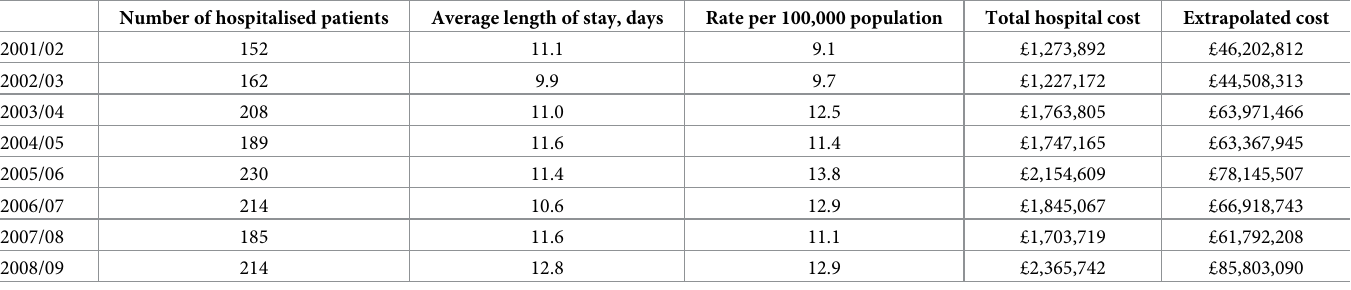
Table 3. Resource use and direct medical costs of acute respiratory illness in hospitalised patients by influenza season in the CPRD/HES population and extrapo- lated to the UK